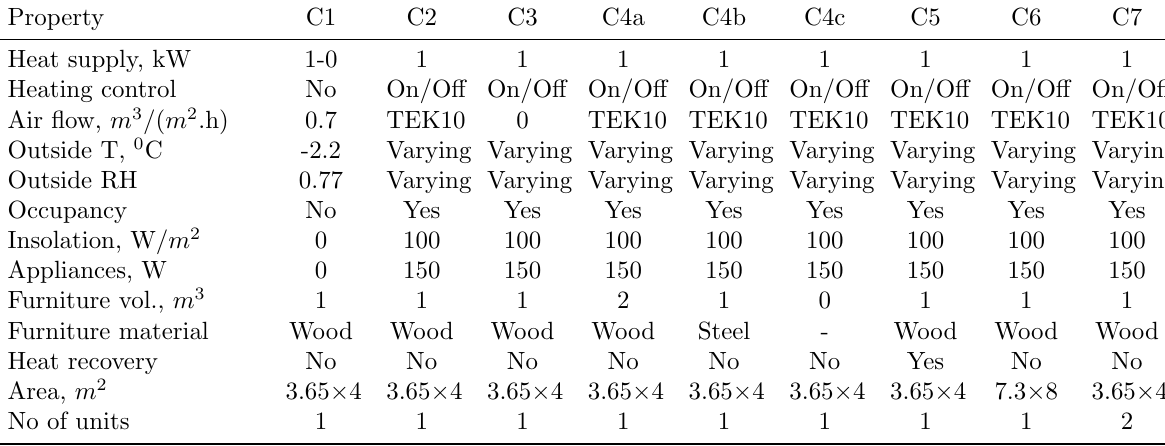
Table 3: Properties of variants in simulated